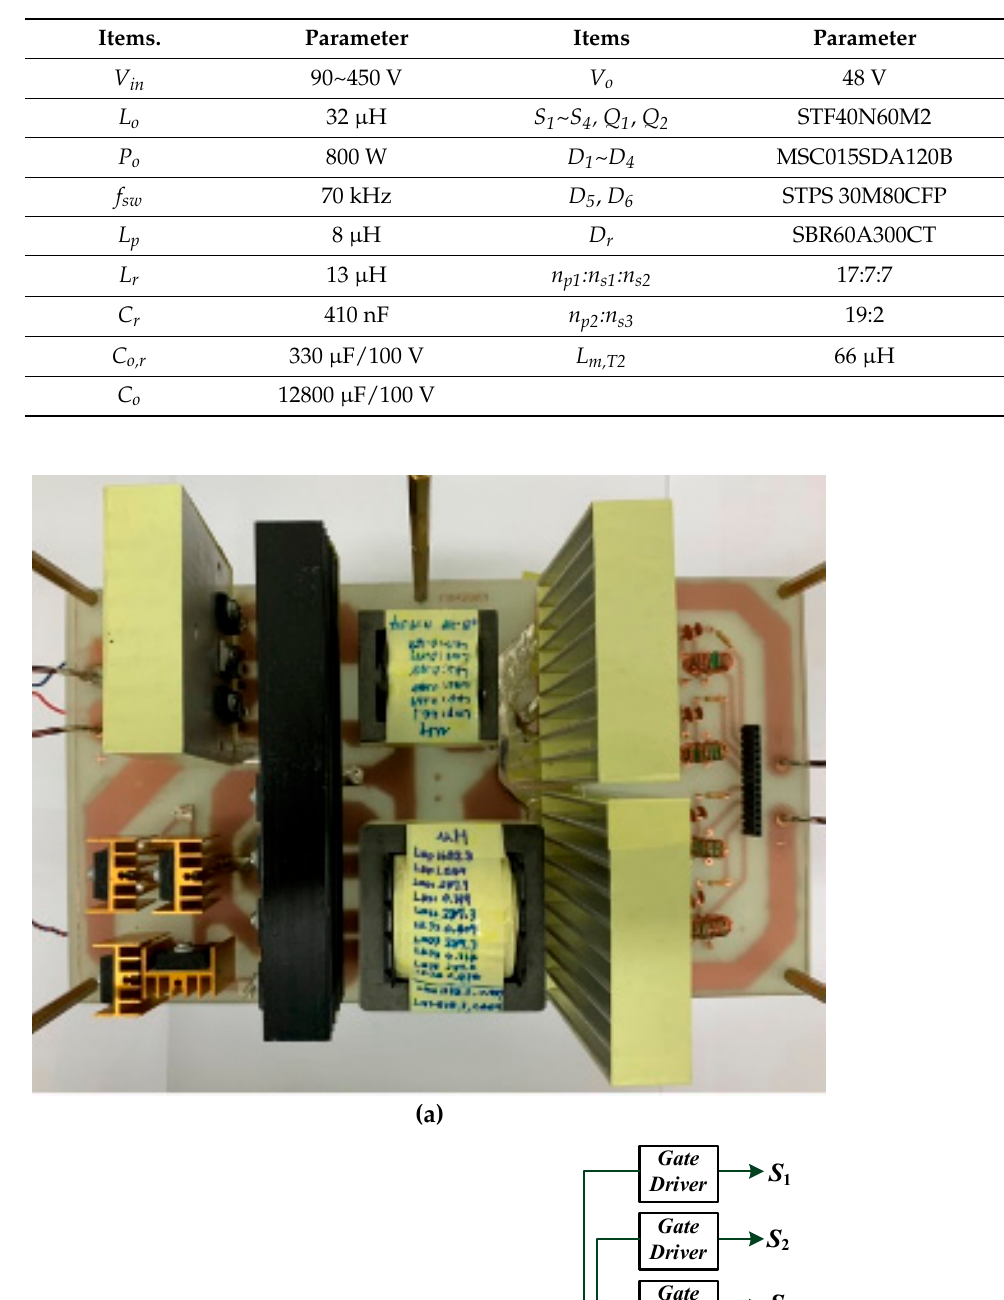
(d) Figure 6. Experimental results at V in = 90 V and full load under low voltage input region ( a ) v S 1 ,g , v S 4 ,g , v ab , and i Lp ( b ) v S 3 ,g , v S 4 ,g , v Cr , and i Lr ( c ) i D 1 , i D 4 , i Dr , and i Lo ( d ) i D 5 , i D 6 , i Dr , and V o,r .